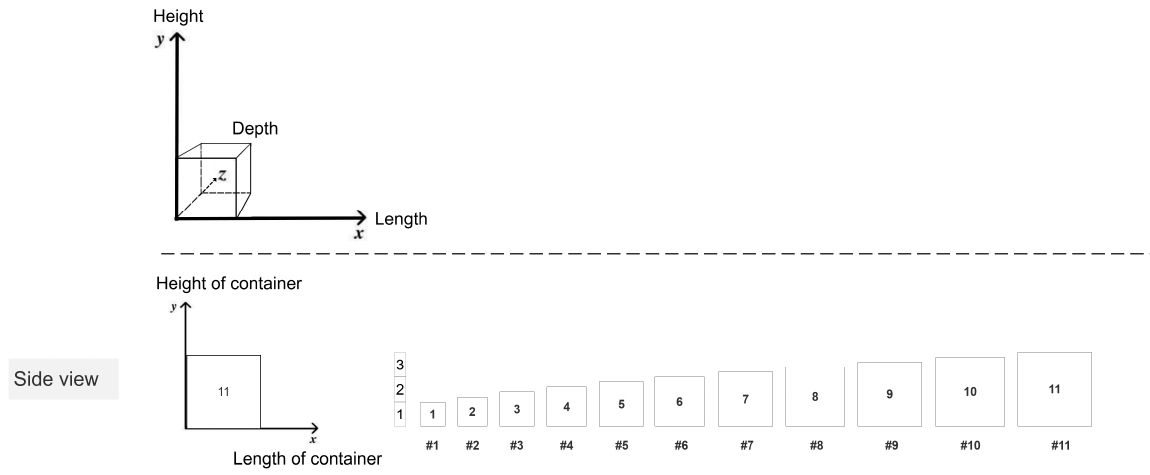
Figure 9. The 11 sizes of cartons.